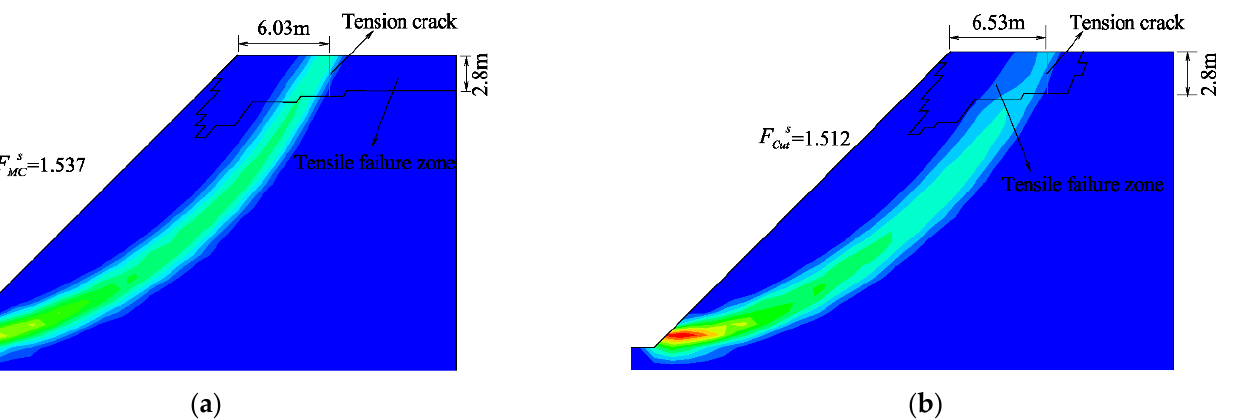
Figure 5. Comparisons of failure mechanisms (1500 elements) . ( a ) failure mechanisms of intact M–C surface; ( b ) failure mechanisms of the cut-off M–C surface.